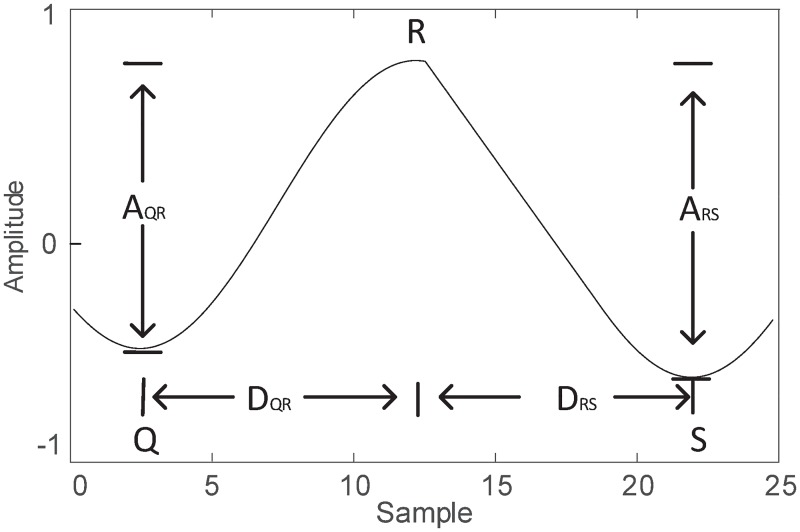
The feature representation of FQRS.Each FQRS is composed of a local minimum (Q-peak candidate), a local maximum (R-peak candidate) and a local minimum (S-peak candidate).